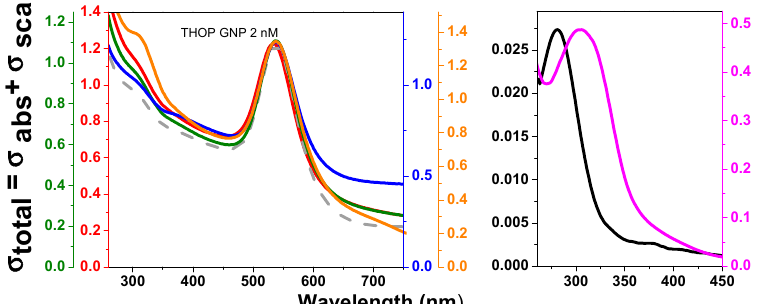
Figure 3. UV-vis spectra of rTHOP-gold nanoparticles (GNPs) synthesized with different THOP concentrations. Spectra of THOP-GNPs were obtained from synthesis using 200, 40, 8 and 2 nM of recombinant THOP. These values correspond to 1200, 240, 48 and 12 nM of exposed sulfhydryls. Red: THOP-GNP 2 nM. Green: THOP-GNP 8 nM. Blue: THOP-GNP 40 nM. Orange: THOP-GNP, 200 nM. Gray dashed line: GNP-HEPES (without protein). Black: THOP protein. Pink: reaction without HEPES. The wavelength of 300 nm corresponds mainly to Au-protein complexes absorption and 535 nm to the surface plasmonic resonance (SPR) band of the nanoparticle. The samples were prepared, and the spectra obtained as described in Materials and Methods.